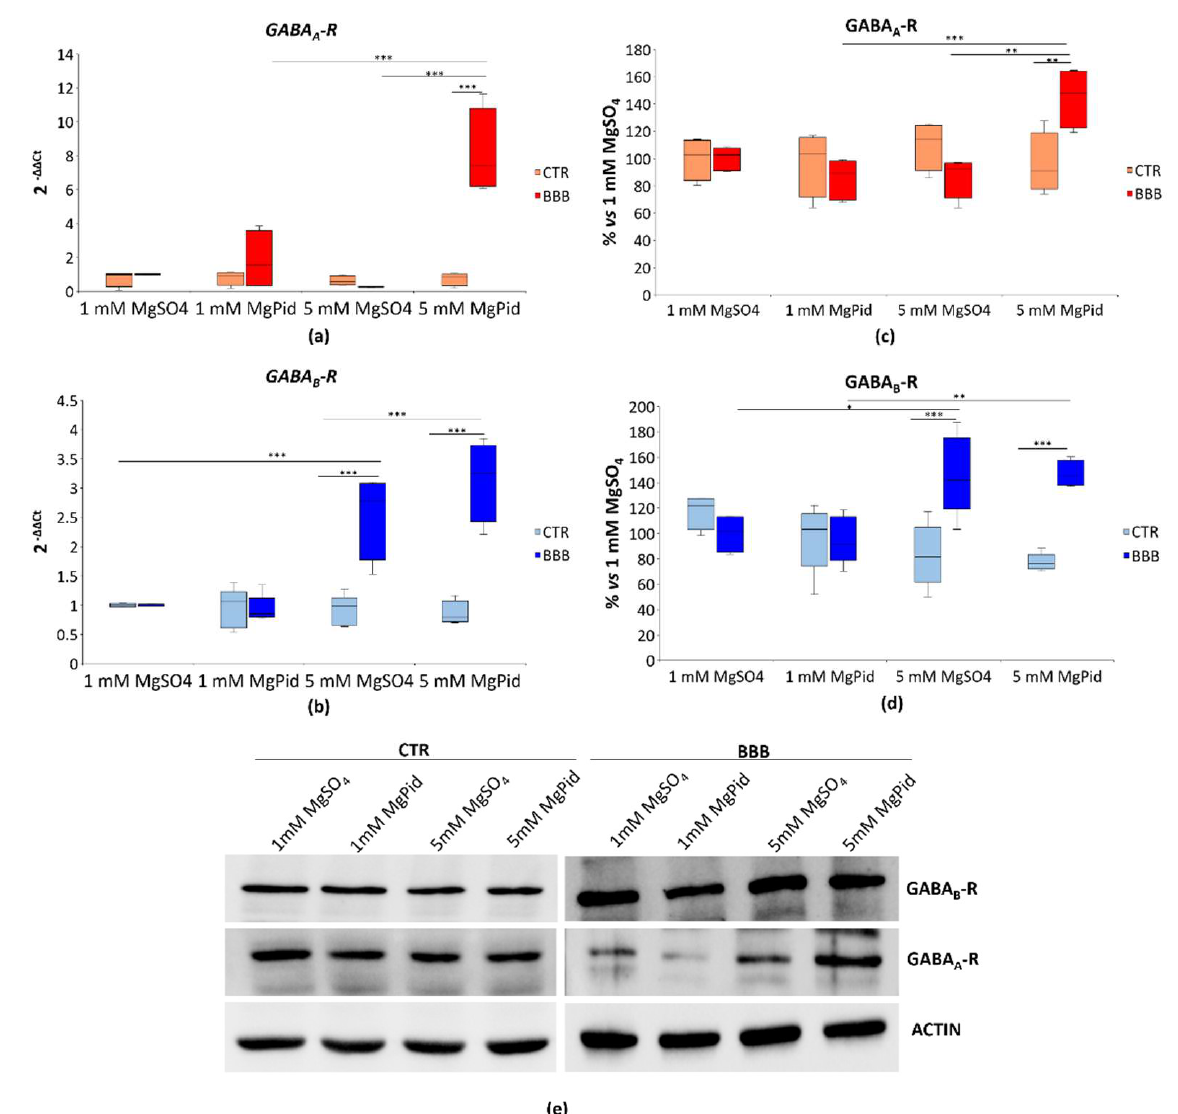
Figure 3. GABA-Rs in brain organoids in the presence or absence of the BBB. Human brain organoids were cultured with (BBB) or without the BBB (CTR) and exposed to 1 or 5 mM MgPid or MgSO 4 for 4 days. Each experimental sample was obtained by pooling three organoids. ( a , b ) Box plot shows the results of the real-time PCR performed at least three times in triplicate on RNA extracted from the brain organoids. Primers were designed on GABRA2 ( GABA A -R ) and GABBR1 ( GABA B -R ) sequences, respectively. The mRNA expression values were normalized to GAPDH mRNA levels; ( c , d ) Western blot was performed using antibodies against GABA A -R and GABA B -R. Actin was used as a control of loading. The box plot shows the quantification of GABA A -R and GABA B -R of five independent Western blots. Each box represents the interquartile range (25th to 75th percentiles), the horizontal line inside is the median value, and the whiskers represent the range; ( e ) A representative Western blot is shown. Two-way ANOVA was performed. * p ≤ 0.05, ** p ≤ 0.01, *** p ≤ 0.001.